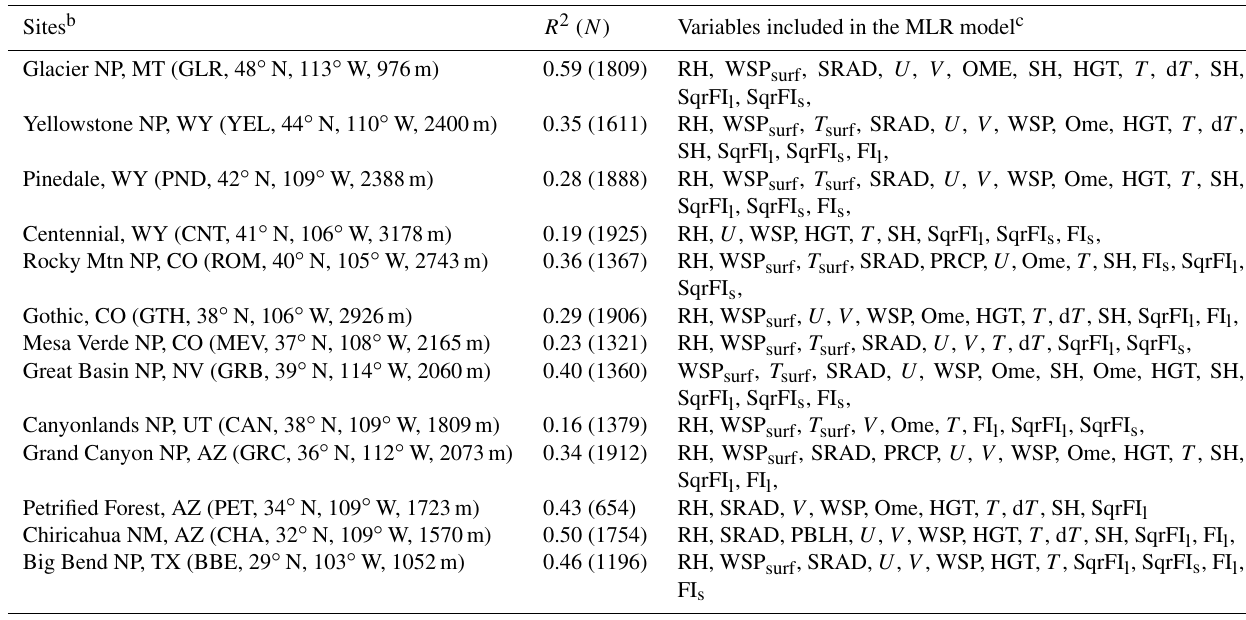
Table 2. Multiple linear regression (MLR) models for summer MDA8 ozone at 13 Intermountain West CASTNet sites a . Sites b R 2 ( N ) Variables included in the MLR model